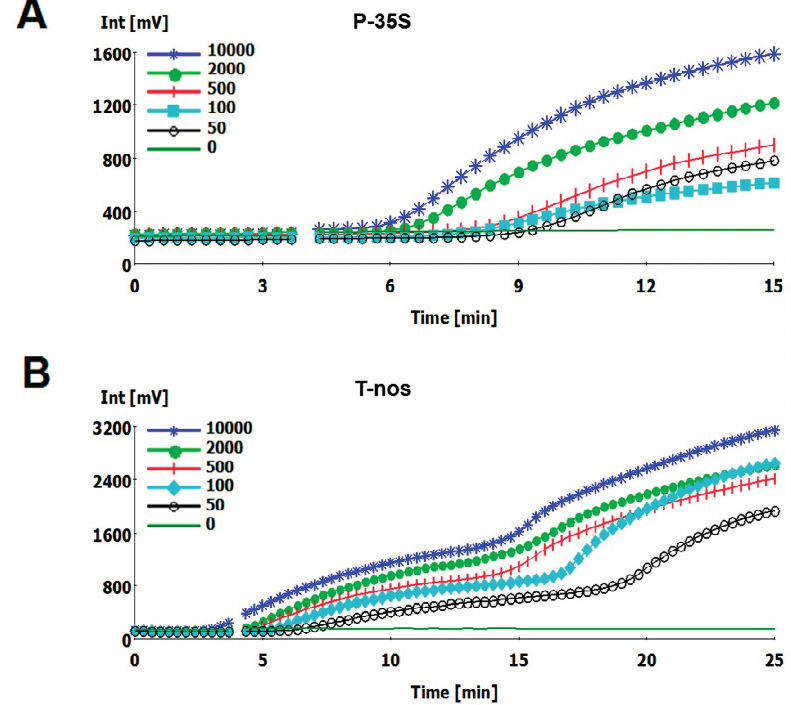
Figure 1. Development of fluorescence intensity (Int) over time for RPA detection for ( A ) P-35S and ( B ) T- nos . 10,000, 2000, 500, 100, 50, or 0 copies of genomic DNA were used as the template.